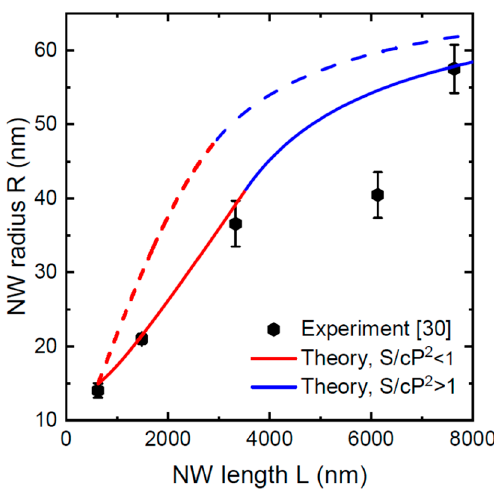
Figure 6. Comparison of the model solutions without (solid line) and with (dashed line) Ga re- emission with the data on the morphological evolution of Ga-catalyzed GaAs NWs grown by MBE on unpatterned GaAs(111)B substrates [30]. The red and blue sections correspond to the solutions before and after the full shadowing of the silica mask,